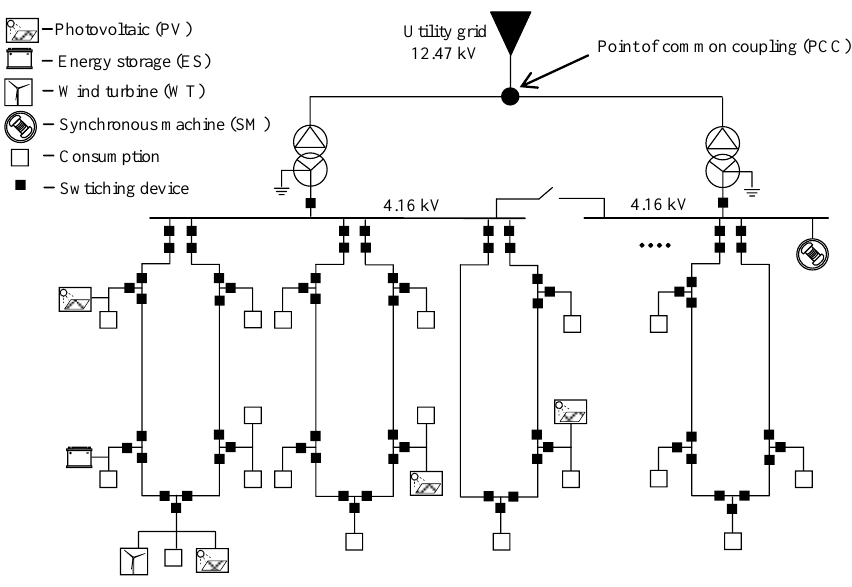
Figure 1. A real-life microgrid example [23]. ranging from gas- or coal-fed synchronous generators, wind turbines, solar PVs, as well as different technologies of energy storages (batteries, flywheels, etc.). They can be directly connected to the grid, completely decoupled from the grid by an inverter, or in some